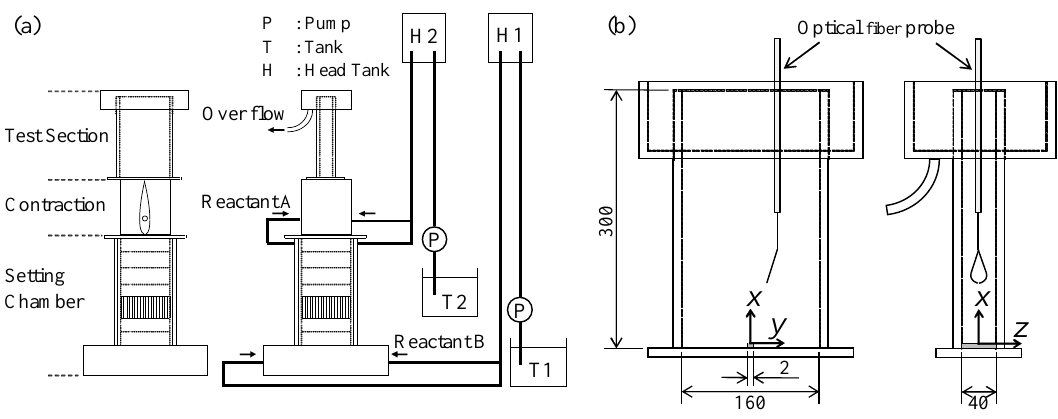
Fig. 2 Schematic of the experimental apparatus (a) and the detail of the test section (b). All dimensions are mm.